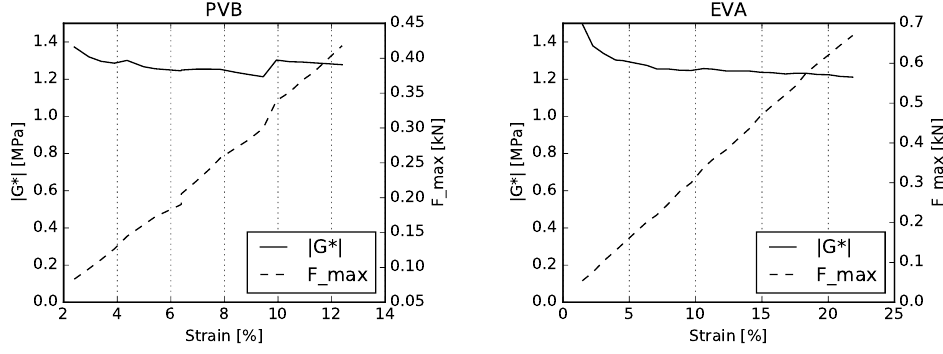
Figure 10. PVB and EVA linearity check for the selected amplitude sweep at a frequency of 1 Hz in the single-lap shear